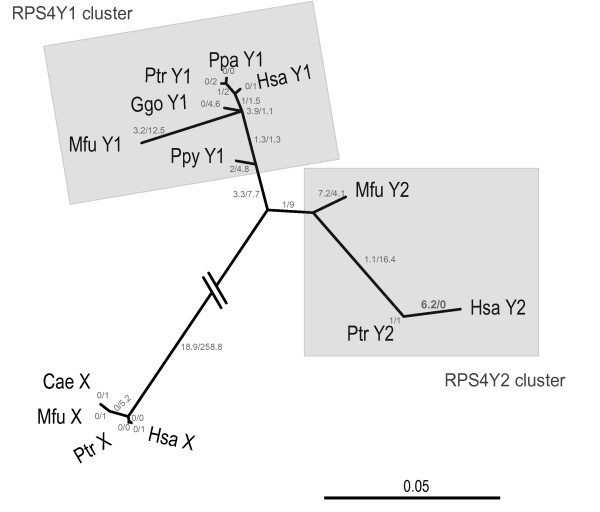
Neighbor-joining tree with model TrNef+G of RPS4X, RPS4Y1, RPS4Y2 cDNAs built with PAUP. Numbers of non-synonymous and synonymous substitutions are shown on each branch. The sequences analyzed were 789 bp long.